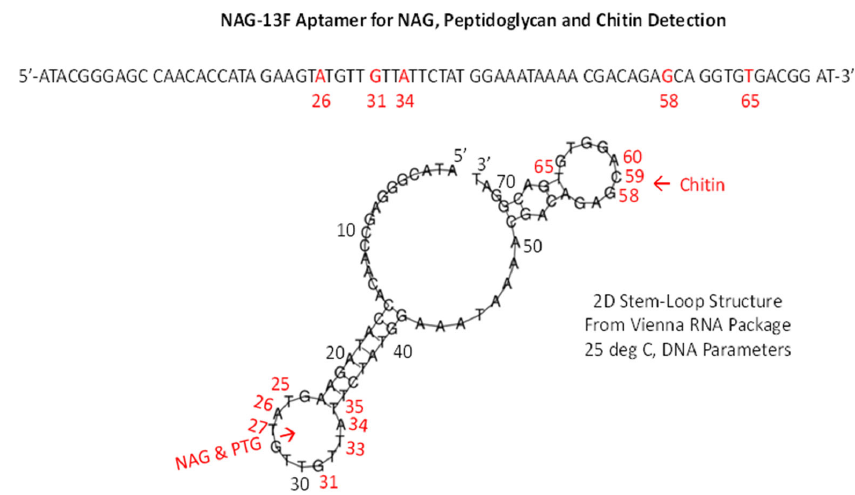
Figure 8. The NAG ‐ 13F aptamer bound to a short segment of peptidoglycan (PTG) pentapeptide shown in RasMol.